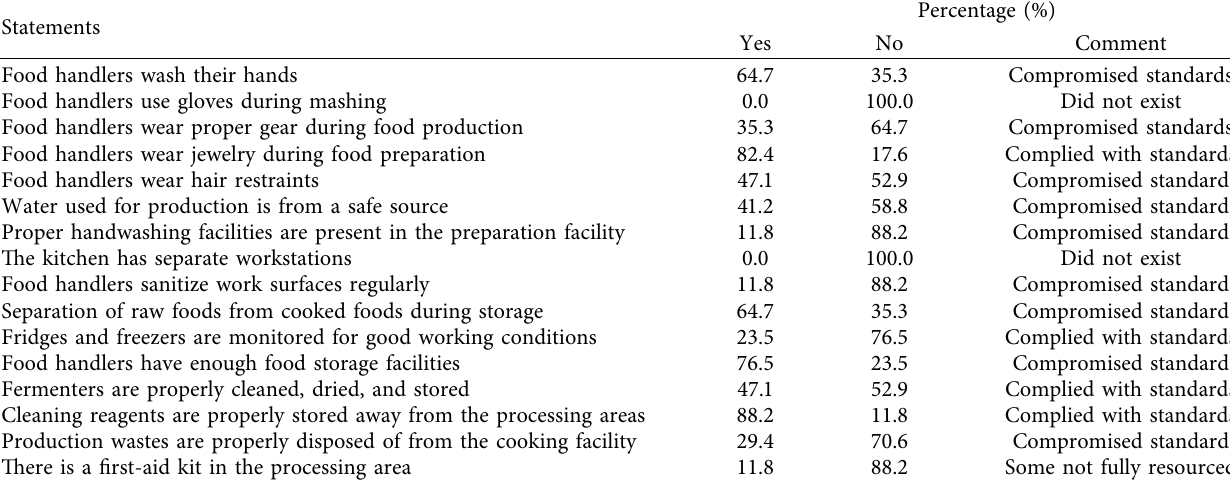
Table 5: Producers’ knowledge in GMP in practice (observation).